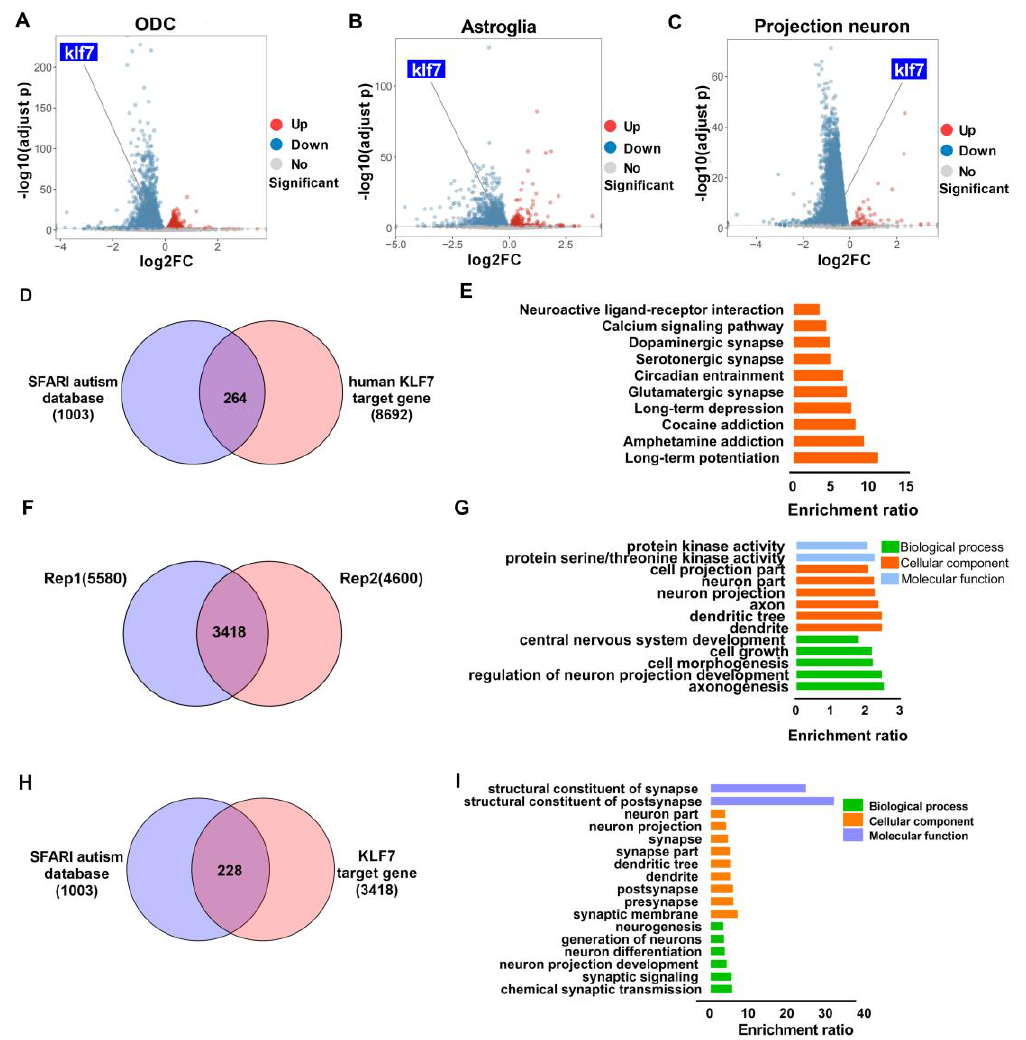
Figure 1. Klf7 targeted genes are enriched for ASD risk genes. ( A – C ) The klf7 level in the prefrontal cortex (PFC) of ASD patients according to human brain single-cell RNA-seq ( n = 16 control, n = 15 ASD patients). Klf7 expression decreased significantly in ODCs (log2FC = − 0.34968, adjusted p = 3.89 × 10 − 8 ), astroglia (log2FC = − 0.42086, adjusted p = 1.09 × 10 − 5 ) and projection neurons (log2FC = − 0.3741, adjust p = 5.94 × 10 − 11 ). ( D ) Shared genes between human klf7 target genes and SFARI autism database. The number of ASD risk genes from SFARI database bound by klf7 is shown, and the total number in each subset is presented in parentheses. ( E ) Functional enrichment analysis of ASD risk genes targeted by human klf7. These ASD risk genes were mainly enriched in processes related to long-term potentiation, circadian rhythm and synapse part. ( F ) Klf7-binding sites in two biological replicates of N2A cells relative to the IgG control. The peak number of biological replicates is shown in the Venn diagram. ( G ) Functional annotation of all klf7 target genes. All genes were enriched in processes related to CNS development and neurons. ( H ) Shared genes between SFARI autism database and klf7 target genes in N2A cells. The number of ASD risk genes in the SFARI database bound by klf7 is given, and the total number in each subset is presented in parentheses. ( I ) Functional enrichment analysis of ASD risk genes targeted by klf7 in N2A cells. These ASD target genes were enriched for functions related to neurons and synapses. ASD, Autism spectrum disorder; klf7, Krüp- pel-like transcription factor 7; ODCs, oligodendroglial cells; log2FC, log2(Fold Change); SFARI, Si- mons Foundation Autism Research Initiative; CNS, central nervous system.